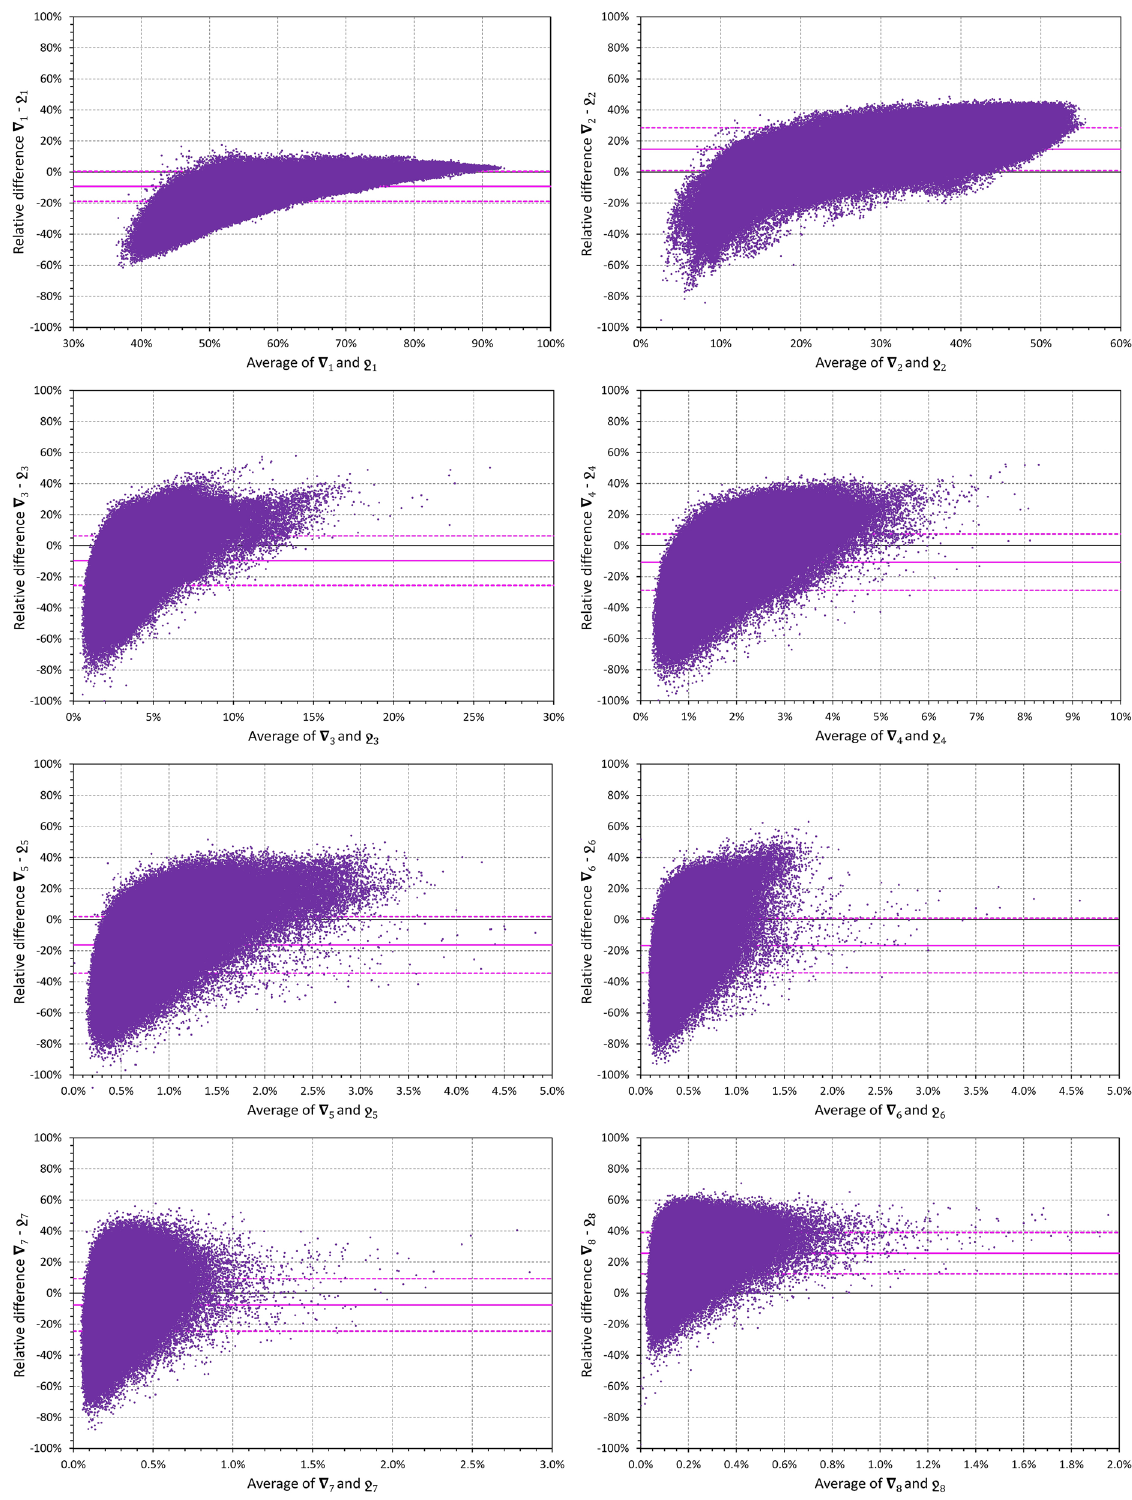
Figure 5. To demonstrate the differences between the decompositions approach that we used and the usual order of eigenvalues, the figure shows Bland–Altman type comparisons of relative eigenvalue proportions and ∇ i for all i , 1 ≤ i ≤ 8. To allow comparison between different components, the vertical values show relative differences, that is values The scatter diagrams show the data of all evaluated 10-s ECG samples, the bold horizontal lines are the means of the relative values, the dashed lines are their means ± standard deviations. Note that the individual data include multiple readings in different subjects and that the values shown in the scatter diagrams are not fully mutually